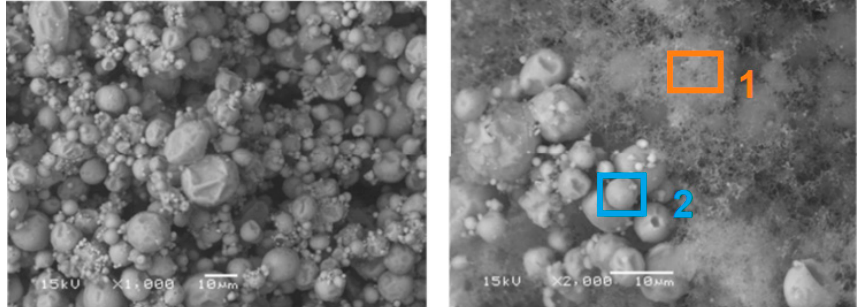
Figure 29. Aluminum particles exposed to 1000 °C (right), 1150 °C (left).